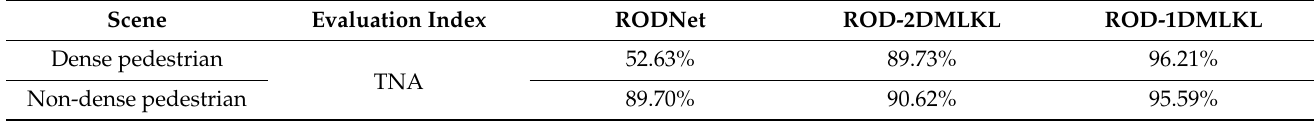
Table 3. Comparison of the TNA of the method proposed in this paper with those in the original paper. Scene Evaluation